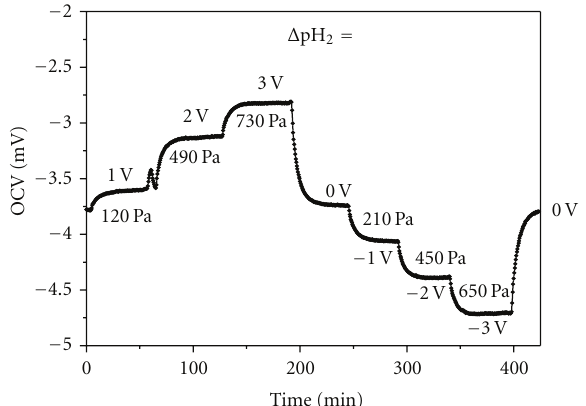
Figure 4: The example results of the hydrogen sensor signal due to hydrogen pumping through the electrochemical pump, as function of applied voltage. Pump and sensor worked at 600 ◦ C, and gas flow rates at both sides were equal to 20Scm 3